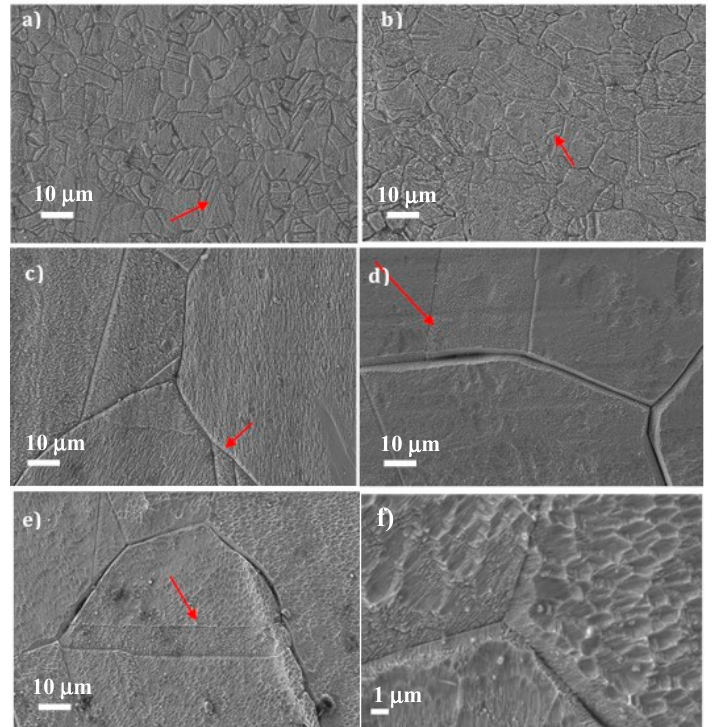
Figure 6. SEM micrographs of chemically attacked copper surfaces: ( a ) sample 0; ( b ) sample 1; ( c ) sample 2; ( d ) sample 3; ( e , f ) sample 4. The read arrows highlight the enlargement of the twins.